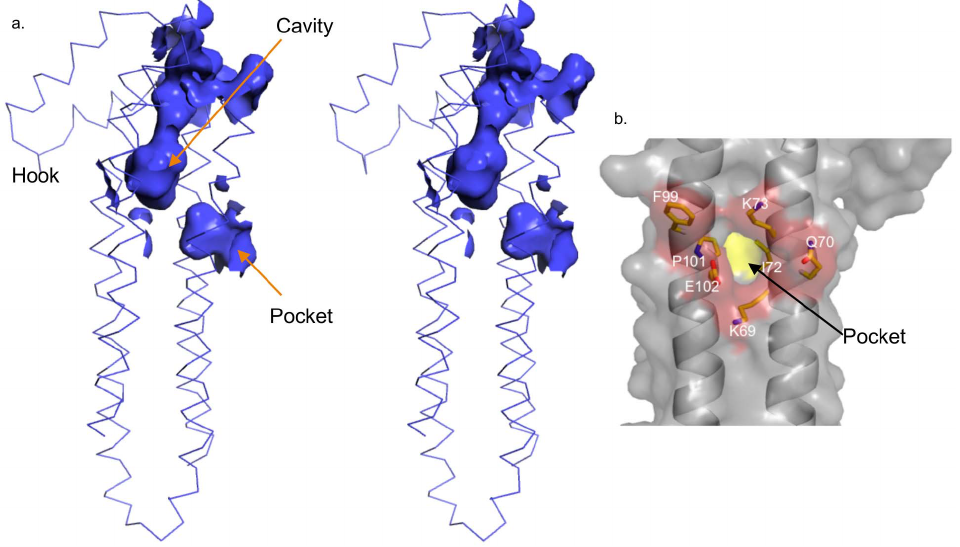
Figure 4. The internal cavity of Pb SPECT1 D 41. a . Stereoview of the interior cavity in Pb SPECT1 D 41 depicted as a surface, and the backbone of Pb SPECT1 D 41 as sticks. The positions of the cavity, pocket, and hook are indicated. b . A molecular surface representation of Pb SPECT1 D 41 with its deep pocket is shown. Residues at the entrance of the pocket are